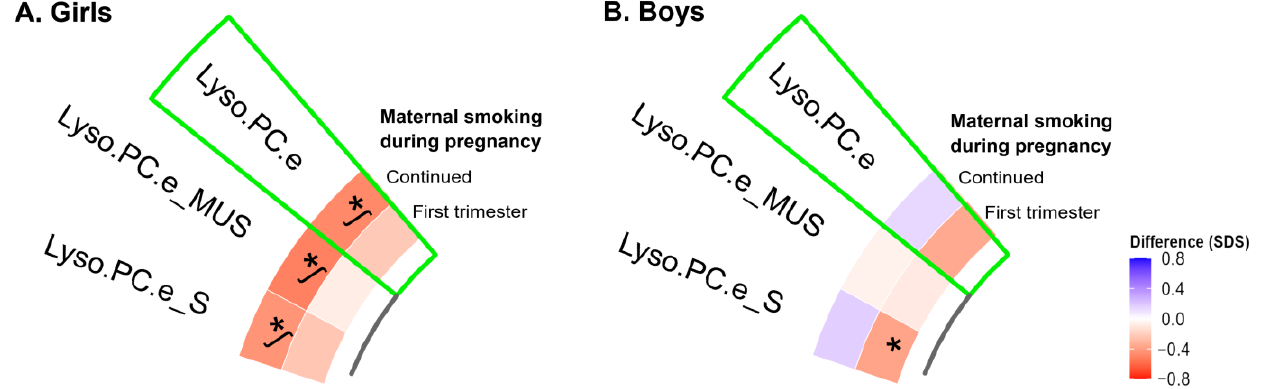
Figure 2. Associations of maternal smoking during pregnancy with cord blood individual metabolite profiles and ratios stratified by sex. Values represent regression coefficients based on linear models that reflect the positive (blue) and negative (red) difference in neonatal cord blood metabolite concentrations in standard deviation scores in neonates whose mothers smoked during pregnancy compared to mothers who did not smoke. Models were adjusted for maternal age, educational level, alcohol consumption, pre-pregnancy BMI, and psychopathology symptoms (confounder model). * p -value < 0.05. ᶴ Significant associations after FDR corrected p -value. The sectors of green color showed the group of neonatal metabolite profile, which is preceded by metabolite profile subgroups. Abbreviations: SDS, standard deviation scores; BMI, body mass index; Lyso.PC.e, alkyl-lysophosphatidylcholines; Lyso.PC.e_S, saturated Lyso.PC.e; and Lyso.PC.e_MUS, mono-unsaturated Lyso.PC.e.